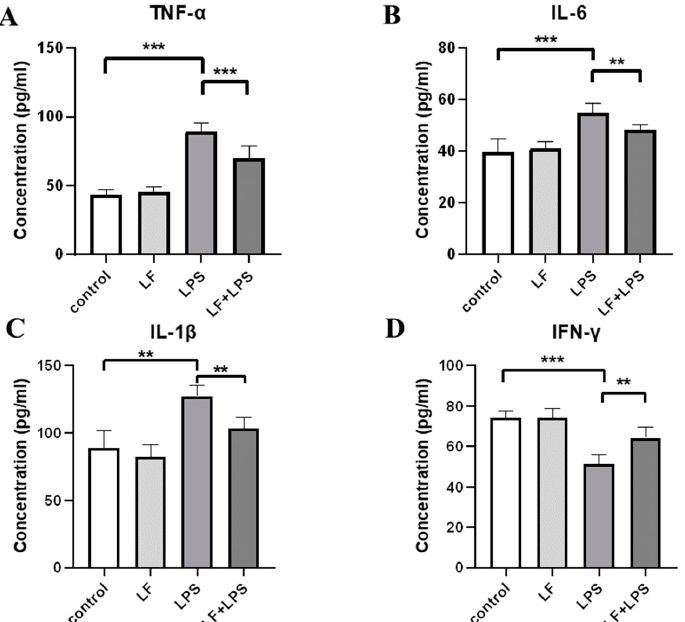
Figure 1. Effect of iron free lactoferrin (apo-LF) on inflammatory cytokines of primary intestinal epithelial cells (IECs) in the co-culture system (primary IECs and immune cells). The concentration of ( A ) pro-inflammatory cytokine TNF- α , ( B ) pro-inflammatory cytokine IL-6, ( C ) pro-inflammatory cytokine IL-1 β and ( D ) anti-inflammatory cytokine IFN- γ in the cell supernatant. Lactoferrin (LF) represents apo-LF. Apo-LF represents individual treatment with 10 g/L apo-LF, lipopolysaccharide (LPS) represents individual treatment with 1 mg/L LPS and apo-LF + LPS represents combined treatment with of 10 g/L apo-LF and 1 mg/L LPS. Data analyzed were presented as means ± SD. ** p < 0.01, *** p < 0.001.